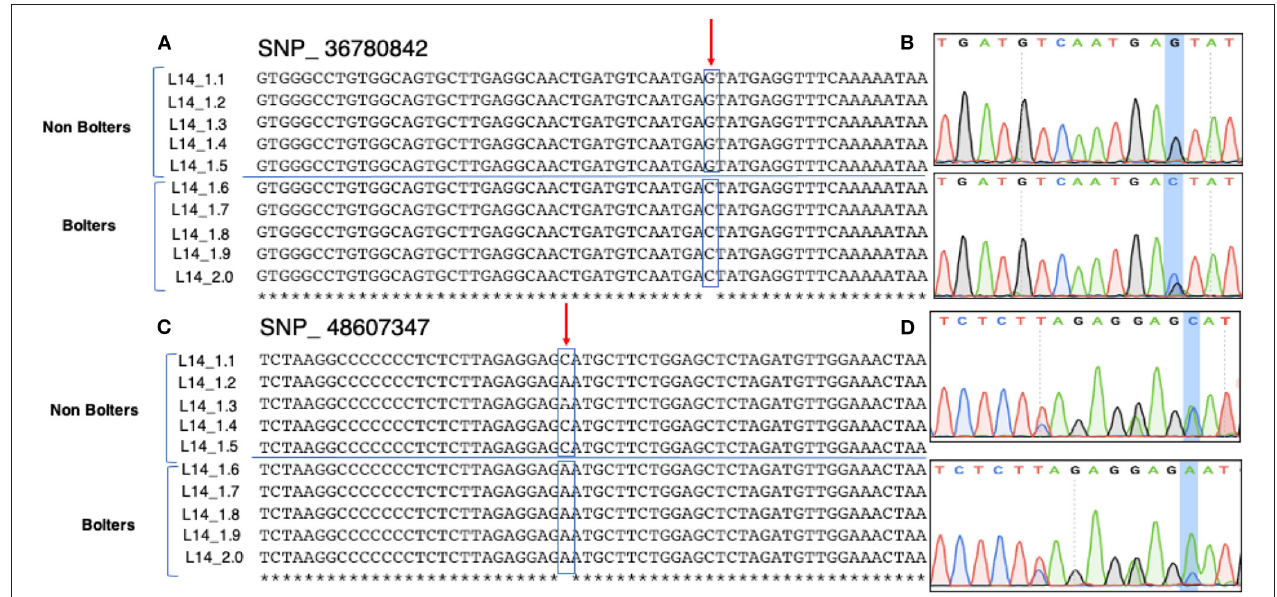
FIGURE 5 | Sanger sequencing-based validation of SNP_36780842 (Chr1, position 36780842) and SNP_ 48607347 (Chr2, 48607347) on five biological replicates of bolters and non-bolters of the L14 line. Top: (A) multiple sequence alignments and (B) the corresponding chromatogram of SNP_36780842 show non-bolters of the L14 line with the G allele. Bottom: (C) multiple sequence alignments and (D) corresponding chromatogram of SNP_48607347 show non-bolters of the L14 line with the C allele. Both SNPs were found to be segregating within the L14 line.